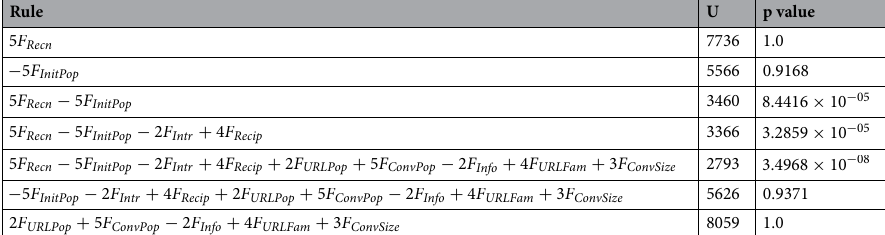
Rule U p value 5 F Recn 7736